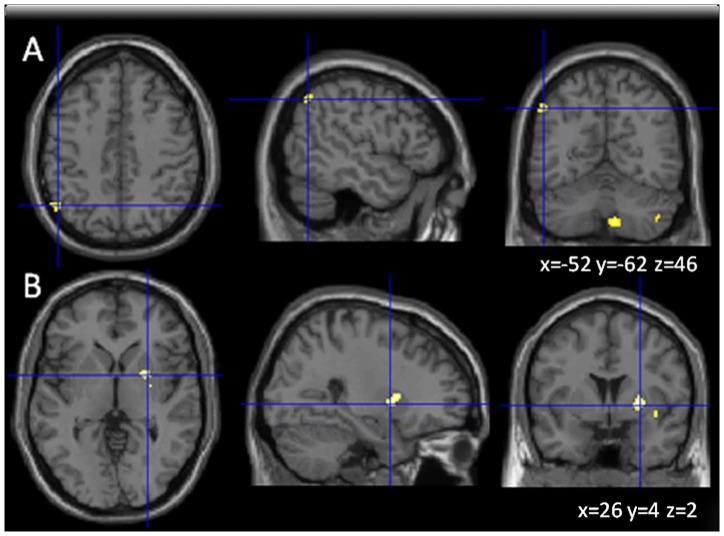
Brain areas showing positive (A) and (B) negative correlation between functional connectivity in relation to the anterior cingulated cortex (ACC) and Symbol Digit Modalities Test performance (SDMT, part of the BRB-N) in MS patients.(Images shown in axial, sagittal and coronal orientation in neurological convention).